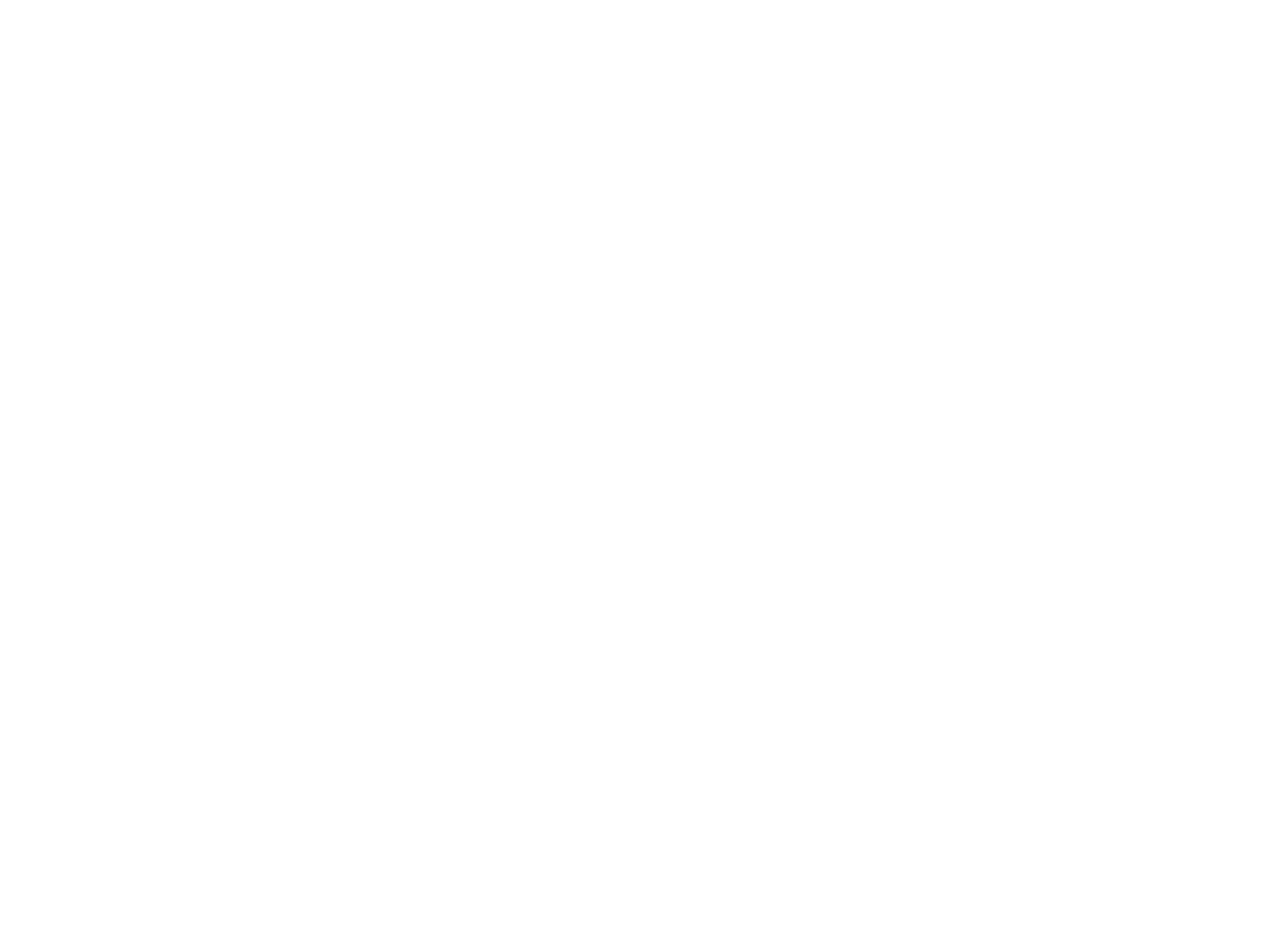
FIGURE A1 | Time series of daily maximum dive depths ( > 10 m) for STs SAMSON (left panel, 15 Feb–30 Aug) and BRICE (right panel, 2 Apr–31 Oct). The position in latitude of the two animals at the beginning of each month is indicated on the top of each